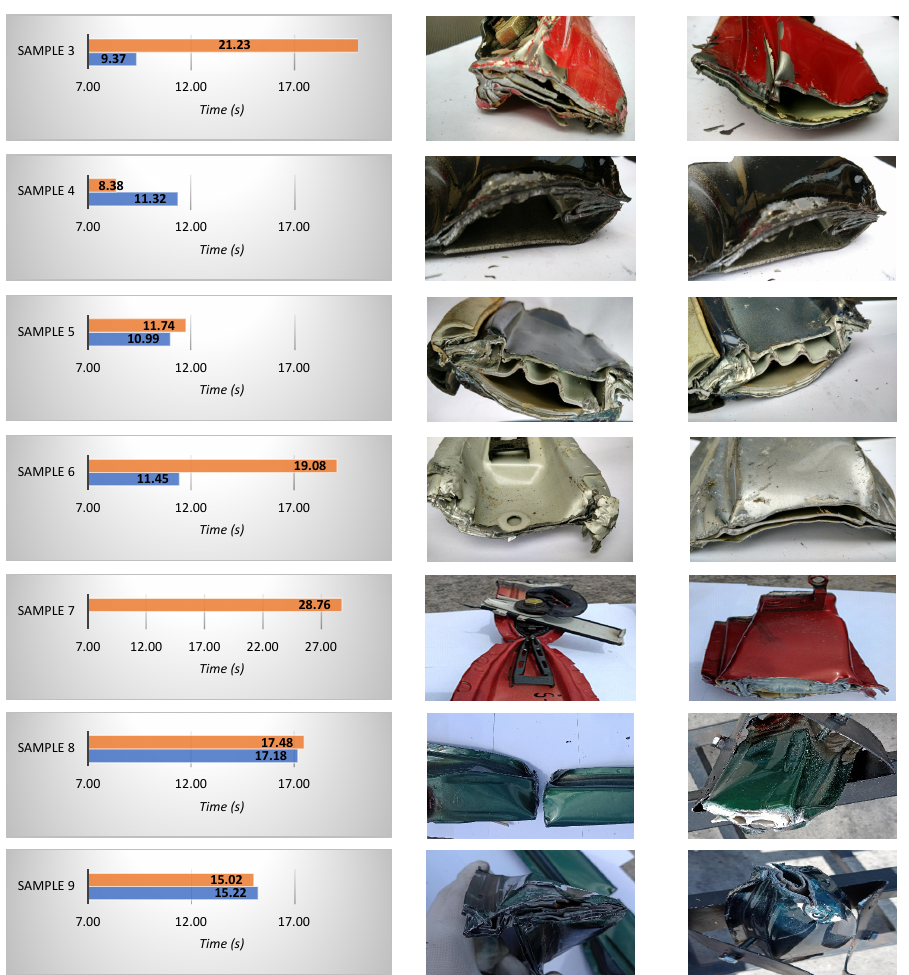
Figure 11. The results of cutting 2/B1 and 2/B2.